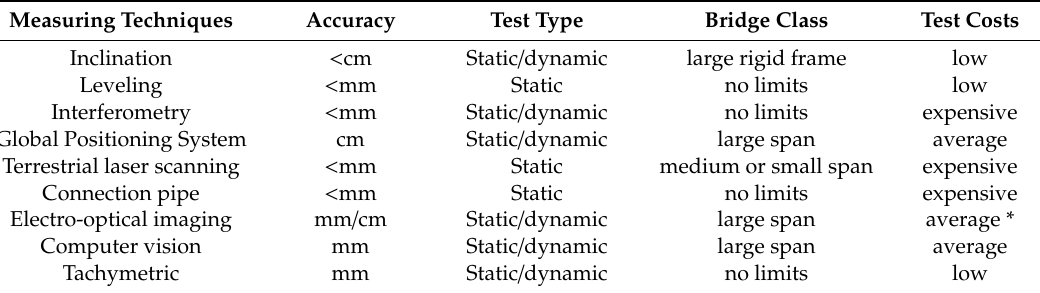
Table 1. A set of displacement measuring